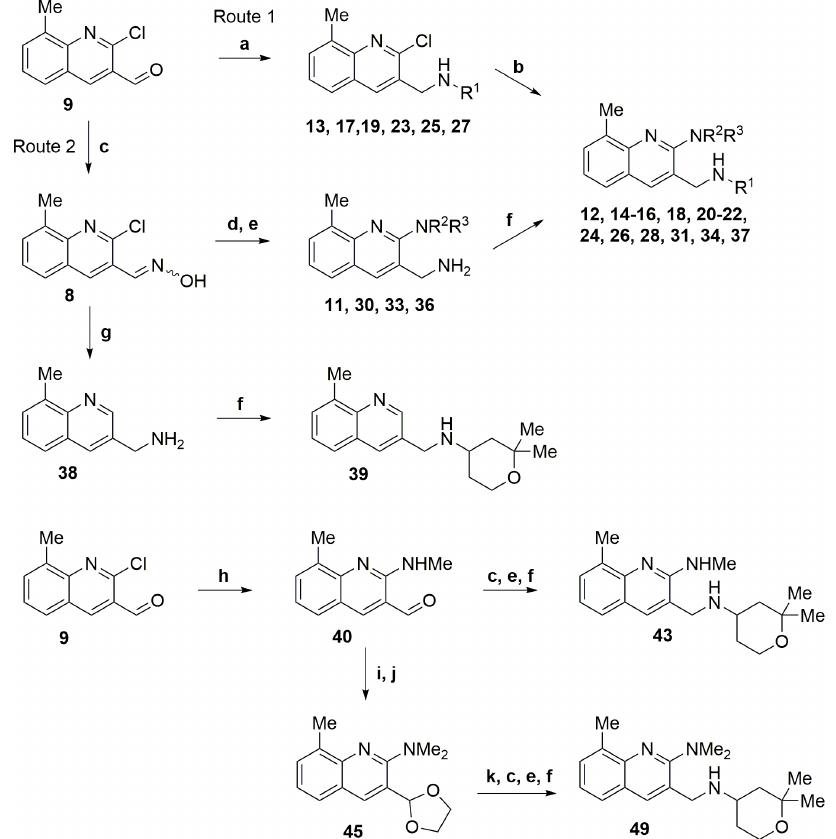
Figure 3 - General strategies for the synthesis of quinoline derivatives. Reagents and conditions: a ) primary amine, CH Cl , then NaBH , MeOH, 83%-quant.; b ) pyrrolidine, 100 2 2 4 °C, 13%-quant.; c ) H NOH.HCl, NaOAc, EtOH, quant.; d ) amine, 100 °C, 77%-91%; e ) 2 Raney-Ni, NH , MeOH, H , 40%-91%; f ) ketone, NaBH(OAc) , CH Cl , 16%-92%; g ) Pd/C, 3 2 3 2 2 H , MeOH, then HCl/Et O, 98%; h ) aq. NH CH , 1,4-dioxane, MW (microwave irradiation), 2 2 2 3 10 min/120 °C, 45 min/160 °C, 75%; i ) ethylene glycol, p-TsOH, toluene, reflux, 91%; j ) CH NaH, DMF (dimethylformamide), 0 °C, 88%; k ) HCl 1M, rt, 95%.